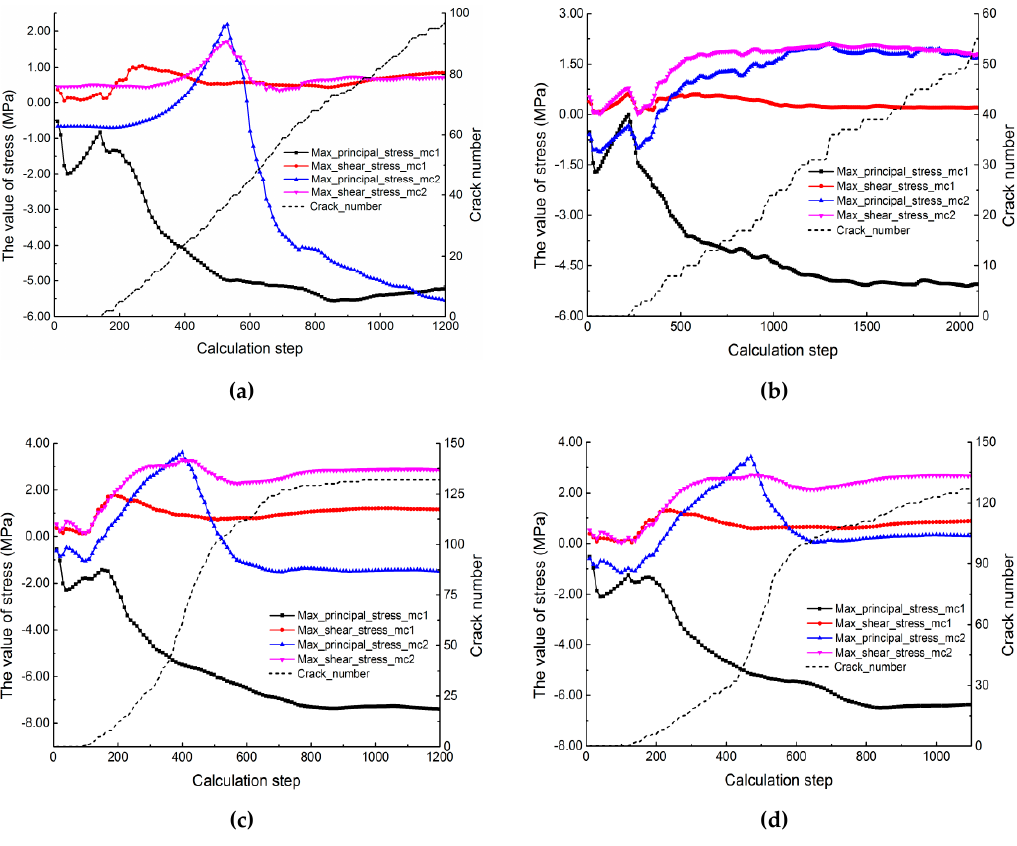
Figure 17. Principal stress curves of the four interactions: ( a ) Group 4A at 45° and 10 MPa; ( b ) Group 4C at 45° and 11 MPa; ( c ) Group 4D at 45° and 11 MPa; and ( d ) Group 4D at 90° and 11 MPa.